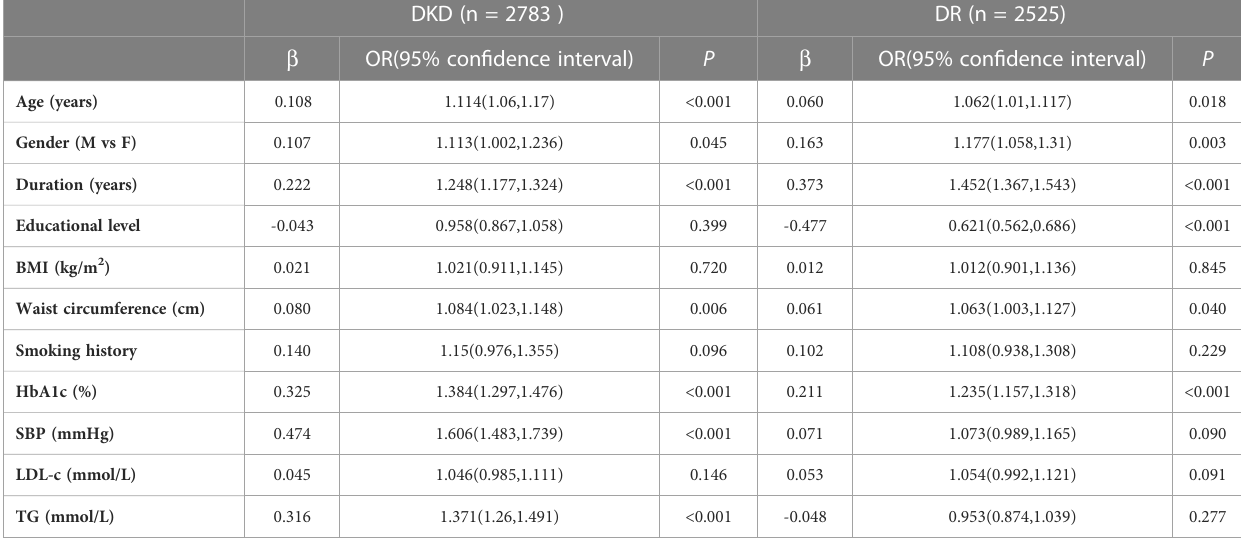
TABLE 3 Comparison of predictors for DKD and DR in all patients (n =